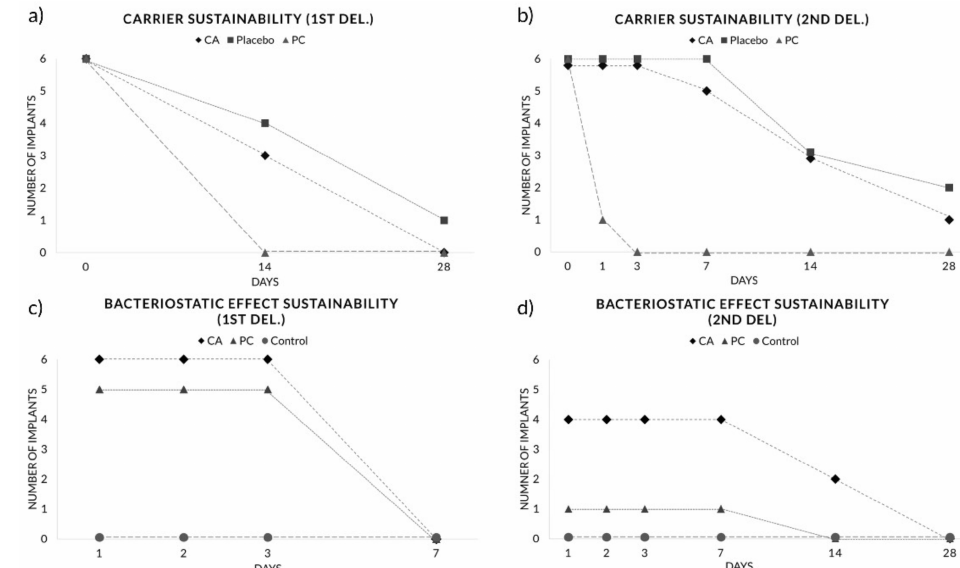
Figure 5. Evaluation of carrier and bacteriostatic e ff ect sustainability—number of implants detected with residual agents at ( a ) the first administration and ( b ) the second administration. Number of implants exhibiting a bacteriostatic e ff ect from broth dilution assay at ( c ) the first administration and ( d ) the second administration.